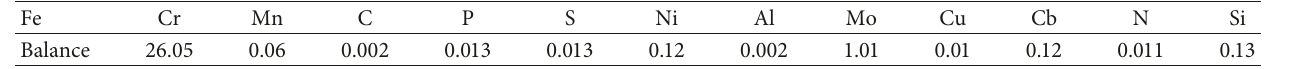
Table 1: Chemical composition (wt.%) of the E-brite substrate alloy.